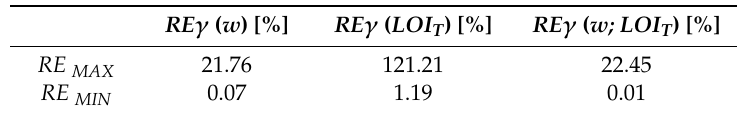
Table 2. Relative error (RE) of the evaluated soil unit weight of organic soil for use in single and two-factor relationships.